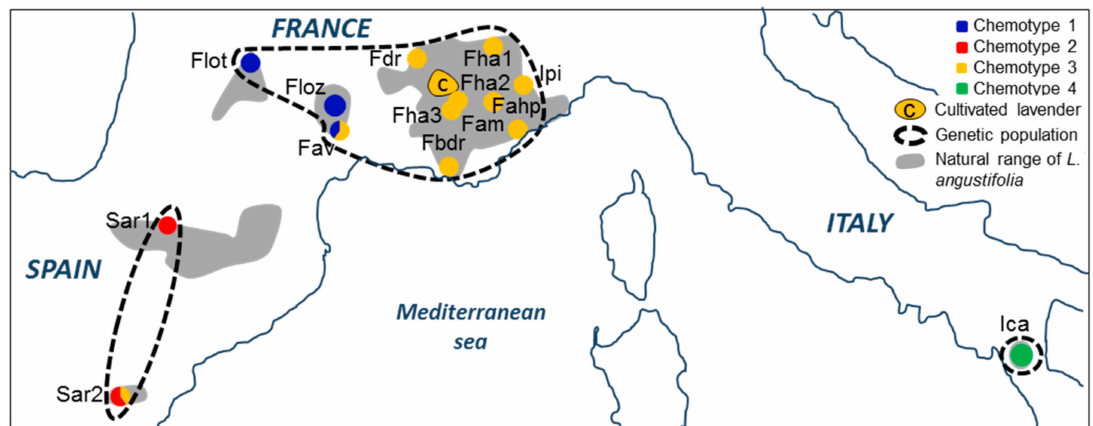
Figure 1. Chemical and genetic structure of the 14 native sampled sites (N = 65) and 5 cultivated fields (N = 25). Grey shading indicates the natural range of the true lavender Lavandula angustifolia . The position of the pie chart indicates the original location of the sampled site. The color of the pie chart designates the chemical cluster membership. The black dashed lines delimit the three genetic units identified with DAPC (discriminant analysis on principal component) on the AFLP (amplified fragment length polymorphism) fingerprinting genotypes. The cultivated fields are grouped in an area with the letter